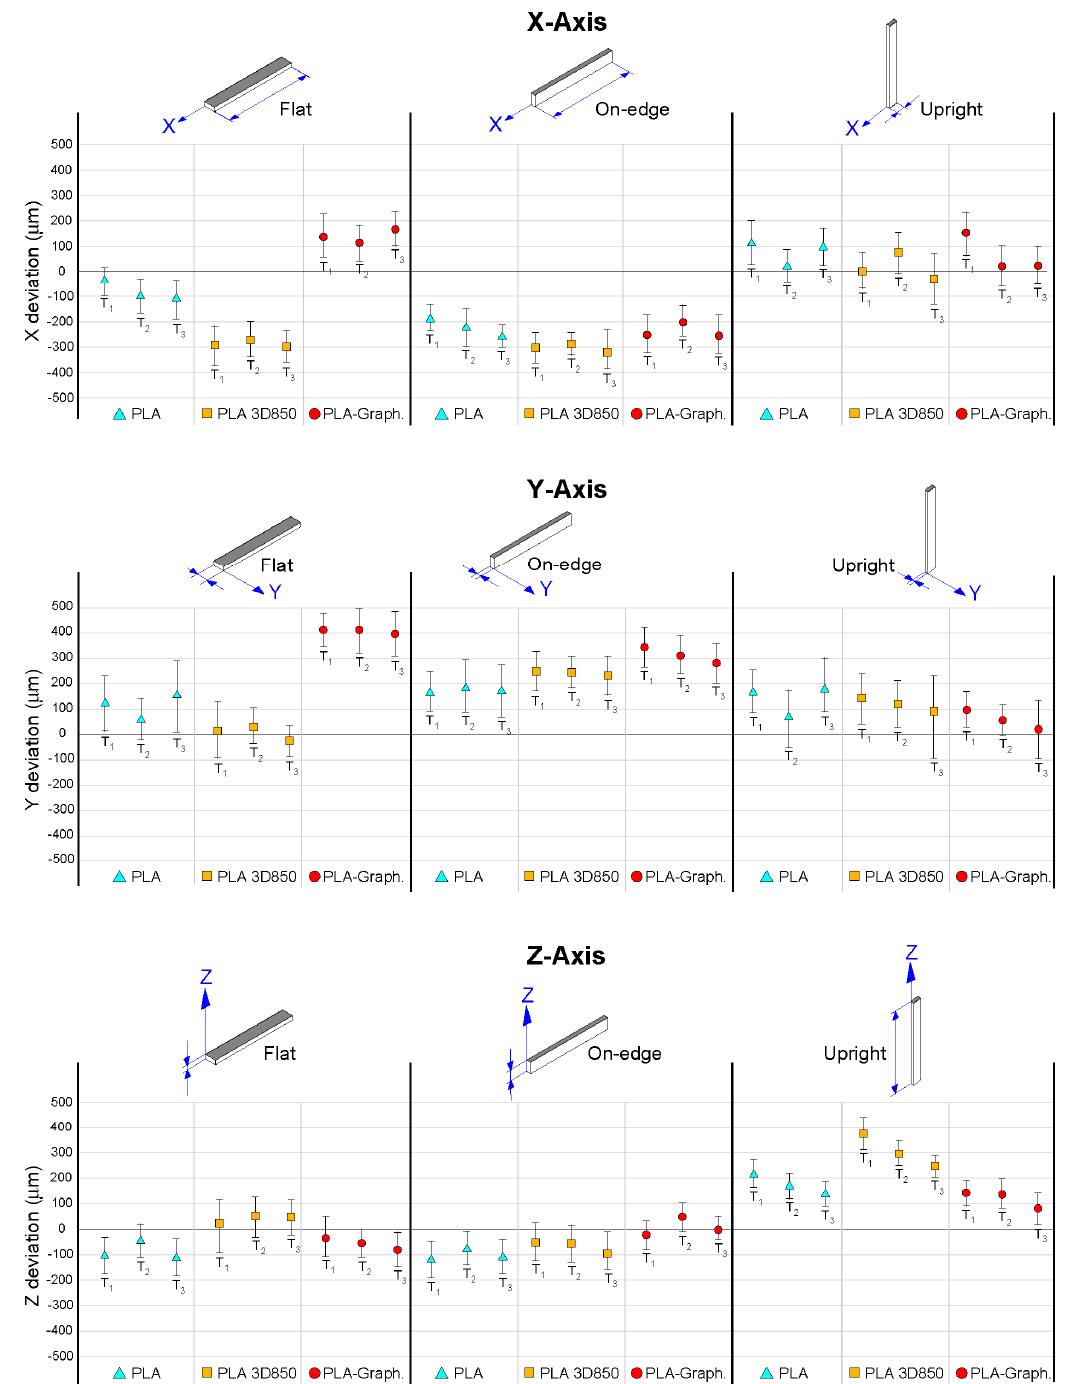
Figure 8. Dimensional accuracy results of PLA-based samples as a function of build orientation and the type of material. The results of three samples of each set are shown, including the mean, maximum and minimum values of each sample for comparative purposes.